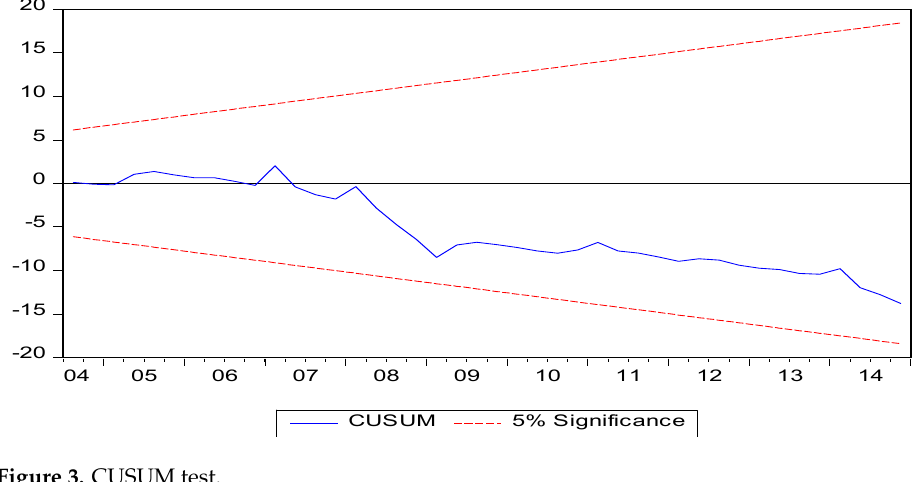
Figure 3. CUSUM test.